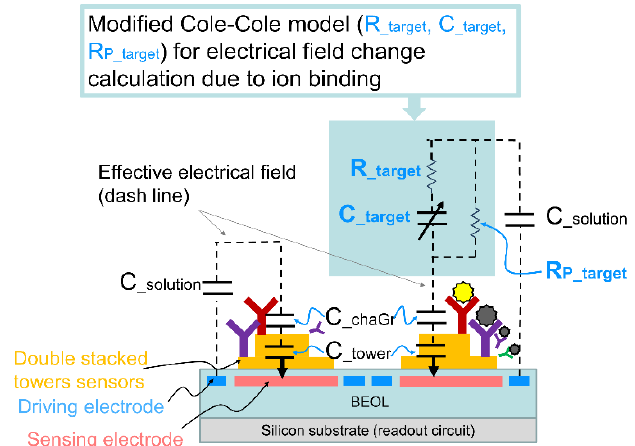
Figure 2. The operation principle of electrical field change when ion binding occurs based on the modified Cole-Cole model. The interaction between charge groups on stacked tower and ions in solution result in the electrical field change. These variations can be sensed as a capacitance change between the driving electrode and stacked tower on the sensing electrode. The saturation point happens on the pH value above pH 10 and below pH 3, in which pH range the modified Cole-Cole model shown in Figure 2 can’t be applied due to high concentration of ions leading a strong electrical field.